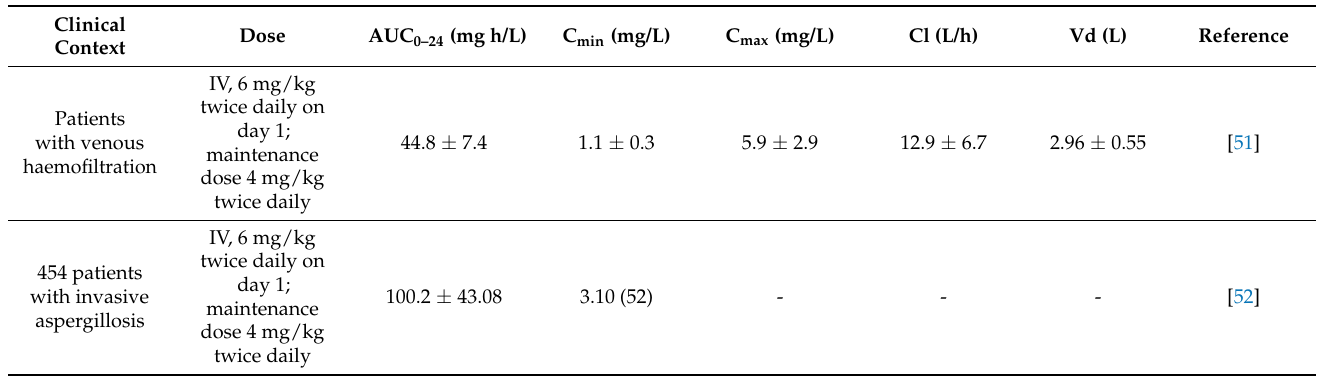
Table 3. Summary of Clinical Studies Assessing PK Parameters of